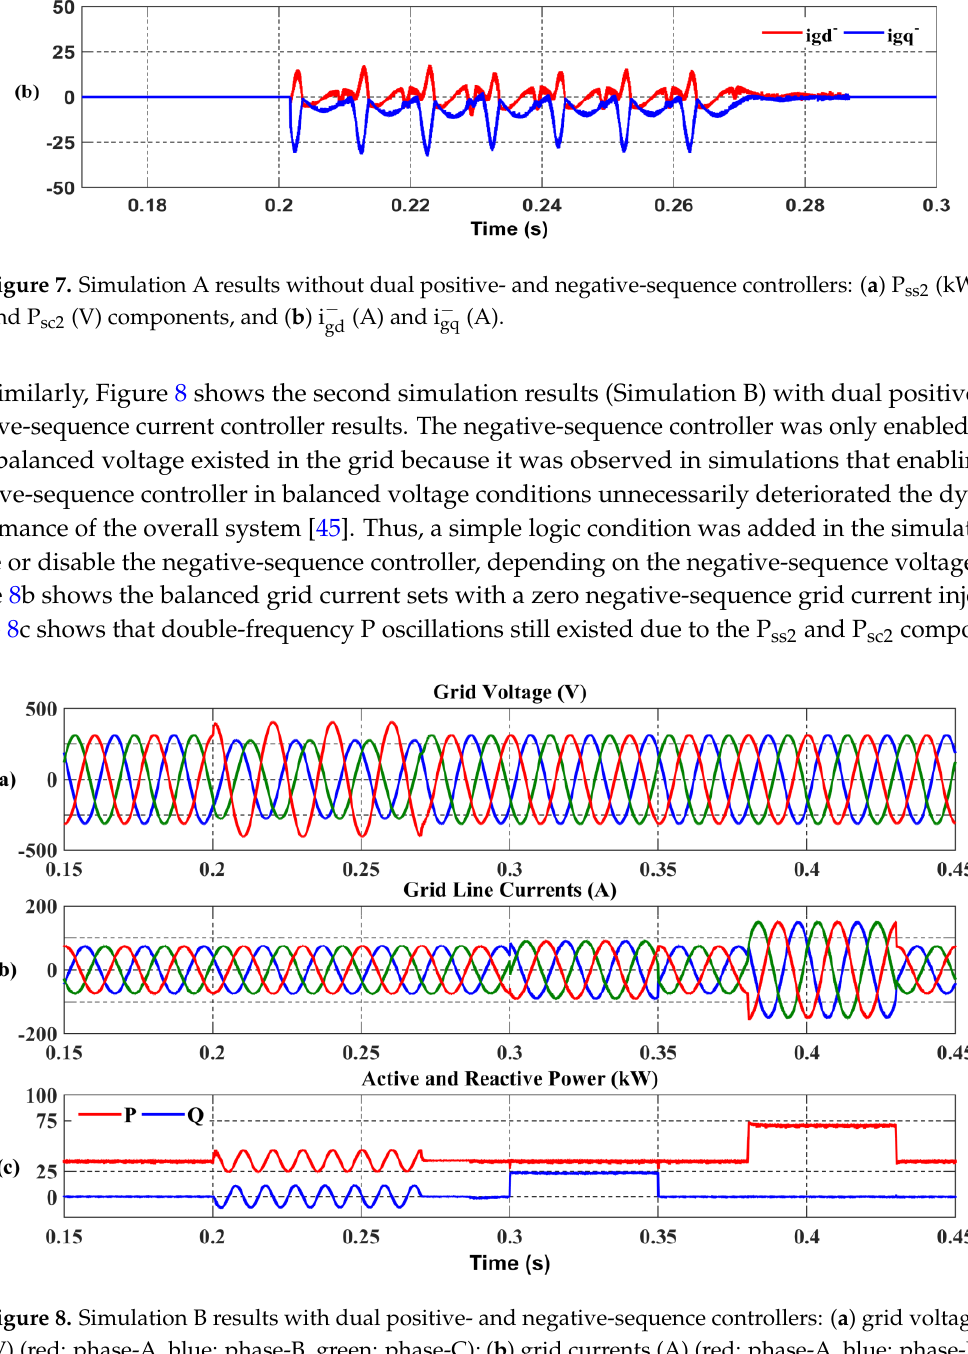
Figure 9. Simulation B results with dual positive- and and negative-sequence controllers: ( a ) positive-sequence dq axis currents (A), ( b ) f gd + and f̂ gd + (V), and ( c ) f gq + and f̂ gq + (V).